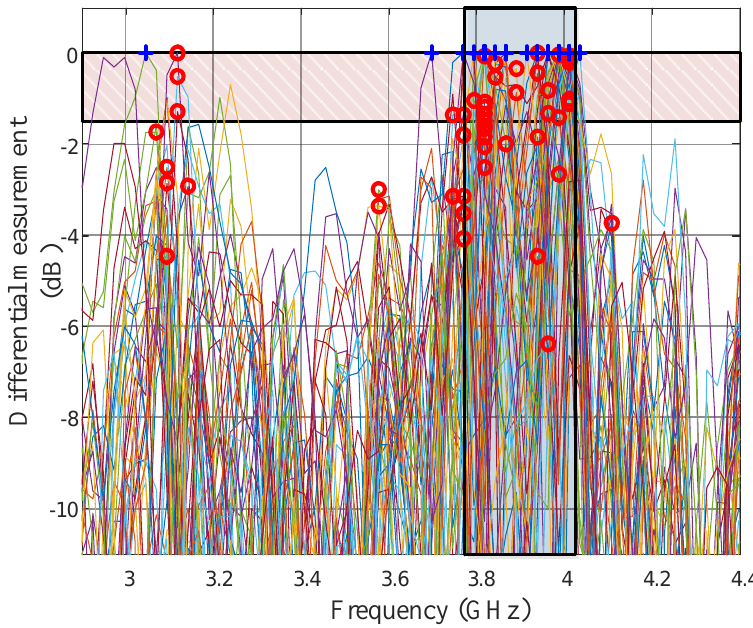
Figure 15. Maximum values of the relative measurement of the 4th scatterer for 50 sequences.